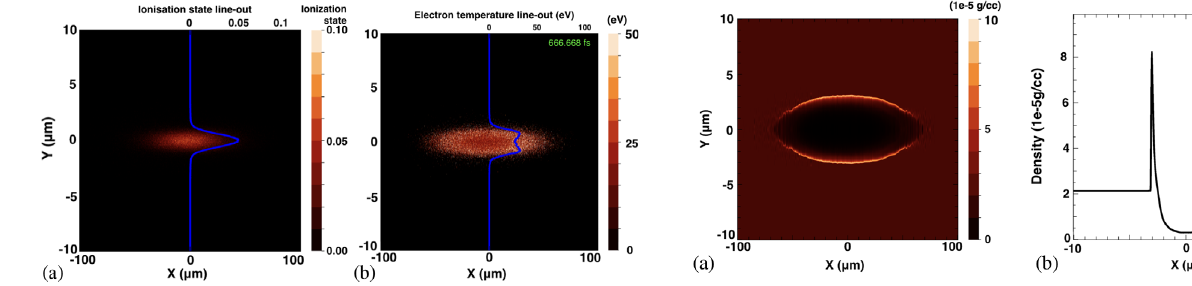
FIG. 2. (a) EPOCH simulations of hydrogen ionization caused by the prepulse. The blue line is an ionization fraction line-out along X ¼ 0 (upper X-axis). (b) Electron temperatures. Here the blue line is an electron temperature line-out along X ¼ 0 (upper X-axis).